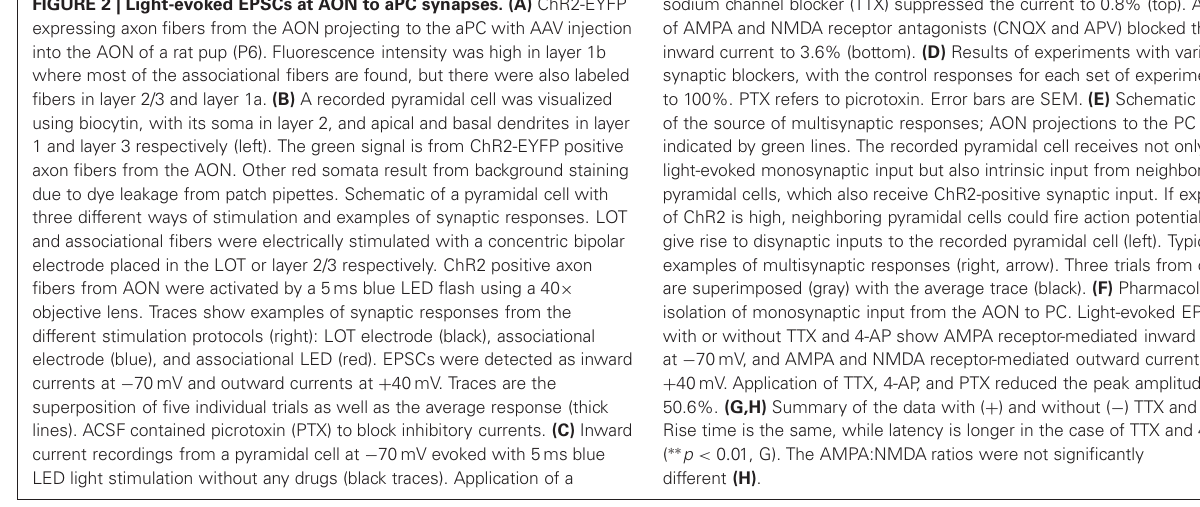
sodium channel blocker (TTX) suppressed the current to 0.8% (top). Addition of AMPA and NMDA receptor antagonists (CNQX and APV) blocked the inward current to 3.6% (bottom). (D) Results of experiments with various synaptic blockers, with the control responses for each set of experiments set to 100%. PTX refers to picrotoxin. Error bars are SEM. (E) Schematic diagram of the source of multisynaptic responses; AON projections to the PC are indicated by green lines. The recorded pyramidal cell receives not only light-evoked monosynaptic input but also intrinsic input from neighbor pyramidal cells, which also receive ChR2-positive synaptic input. If expression of ChR2 is high, neighboring pyramidal cells could fire action potentials and give rise to disynaptic inputs to the recorded pyramidal cell (left). Typical examples of multisynaptic responses (right, arrow). Three trials from one cell are superimposed (gray) with the average trace (black). (F) Pharmacological isolation of monosynaptic input from the AON to PC. Light-evoked EPSCs with or without TTX and 4-AP show AMPA receptor-mediated inward current at − 70mV, and AMPA and NMDA receptor-mediated outward current at + 40mV. Application of TTX, 4-AP, and PTX reduced the peak amplitude to 50.6%. (G,H) Summary of the data with ( + ) and without ( − ) TTX and 4-AP. Rise time is the same, while latency is longer in the case of TTX and 4-AP ( ∗∗ p < 0 . 01, G). The AMPA:NMDA ratios were not significantly different (H)